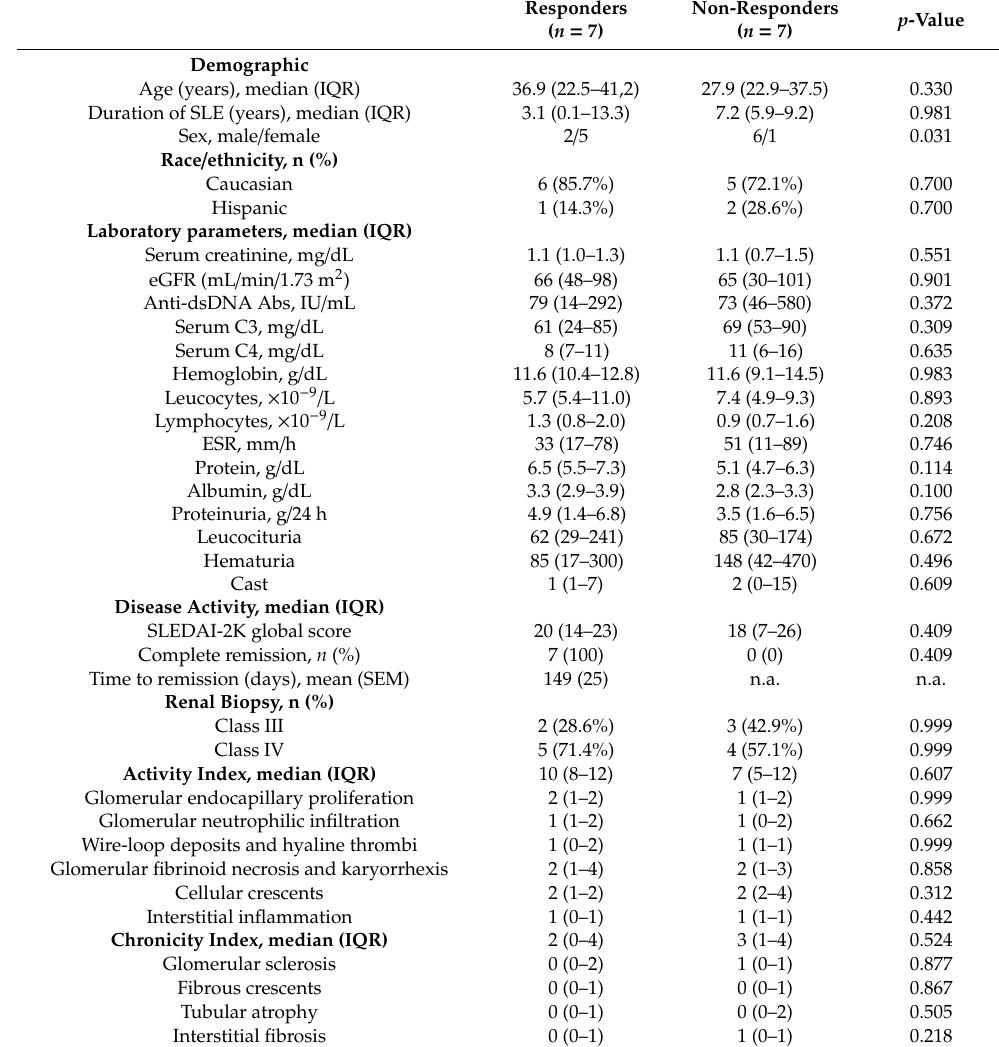
Table 1. Baseline demographic, laboratory, and clinical data from the screening